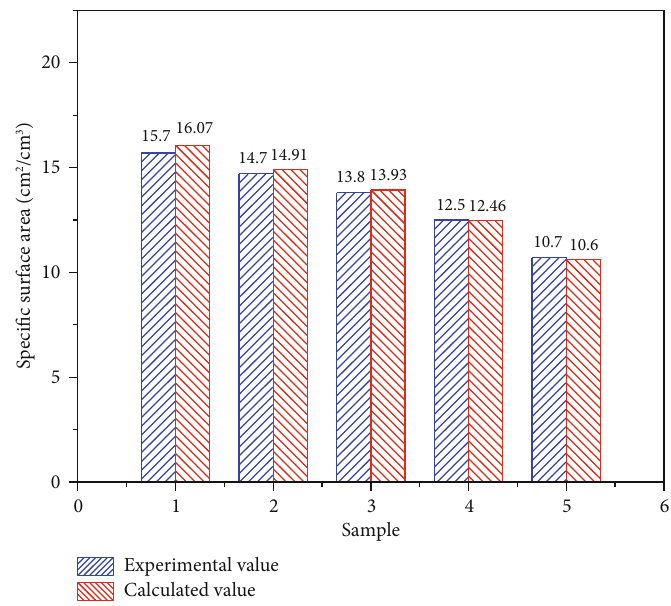
Figure 7: Comparison of experimental and calculated values of foamed aluminum speci fi c surface area.